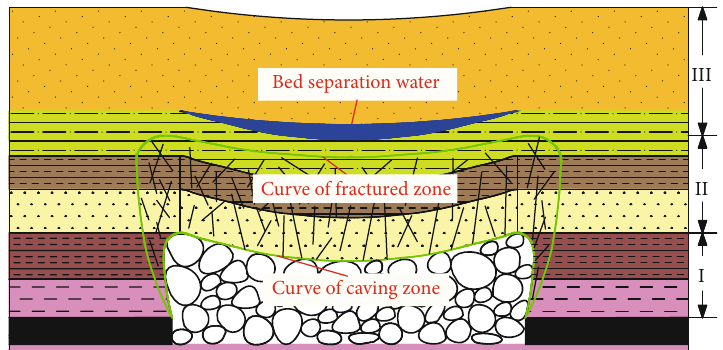
Figure 1: Illustration of separation development in a mine.